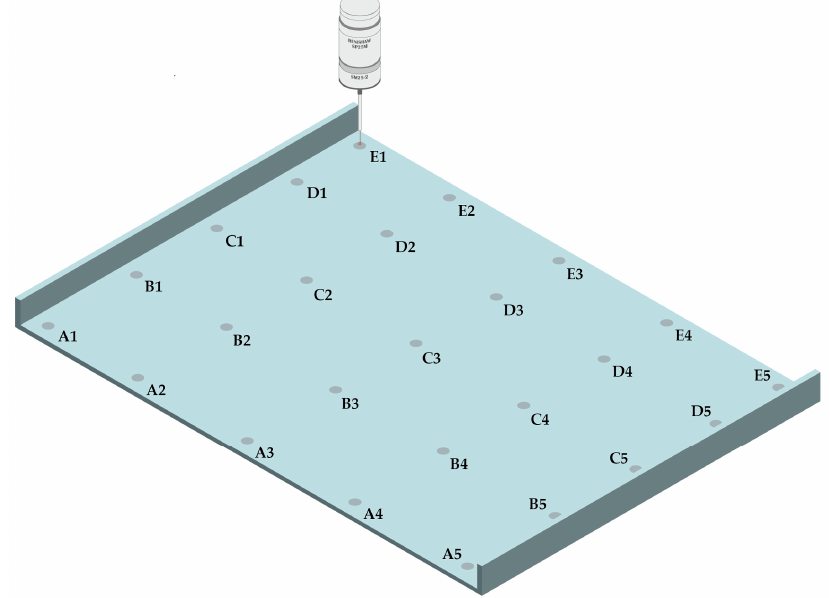
Figure 4. The measuring points.